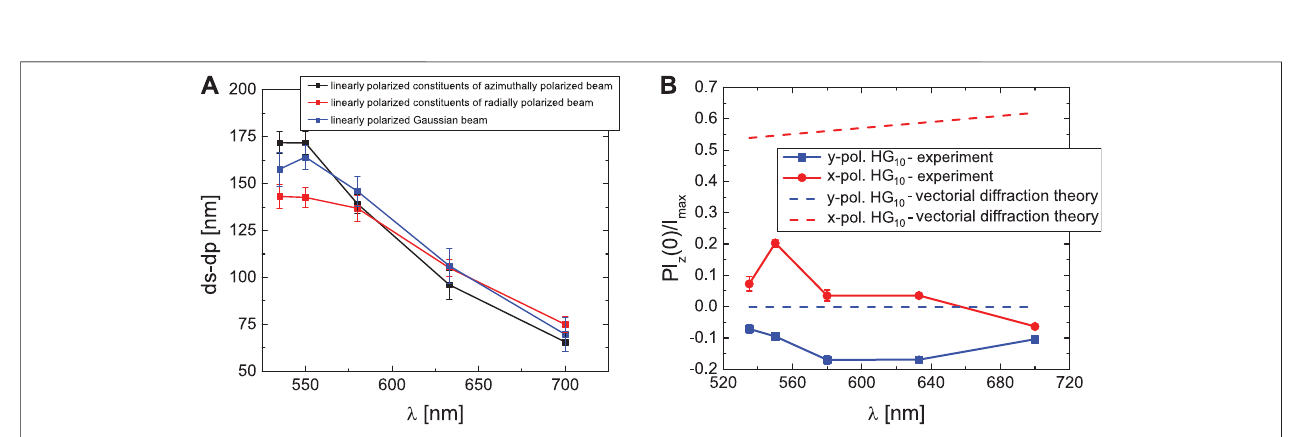
FIGURE7| Experimentallymeasuredrelativeshift d s − d p forlinearly, s -and p -polarizedGaussianbeams(black)andforthelinearly s -and p -polarizedconstituents ofradially(red)andazimuthally(blue)polarizedbeamsfordifferentwavelengths λ (A) .Comparisonbetweentheprojectedintensity(PI)forthe z -componentoftheelectric fi eld in the center of the measured beam (experiment) and numerically obtained values from vectorial diffraction theory [3] (B) .